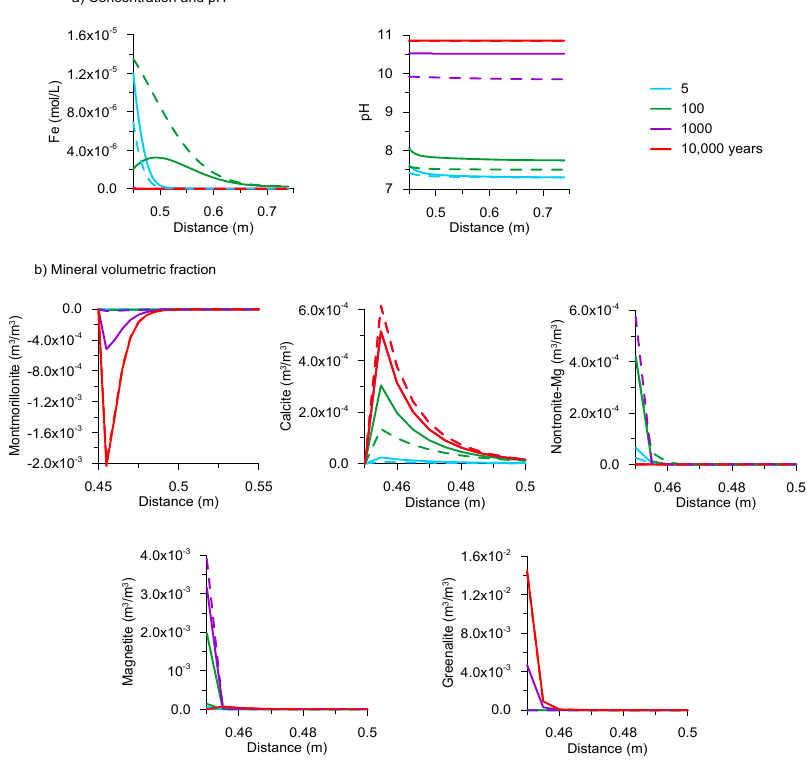
Figure 5. Results for the numerical model with a corrosion rate of 10 µ m y − 1 (continuous lines) are compared with those from the reference model (r = 2 µ m y − 1 , dashed lines). The interface between steel and bentonite is at 0.45 m. Results at 5, 100, 1000 and 10,000 years of interaction are given. ( a ) Fe concentration and pH against distance and ( b ) volumetric fraction of minerals versus distance. For the primary phases (montmorillonite and calcite) the variation of the volumetric fraction is plotted. Positive values mean precipitation and negative values mean